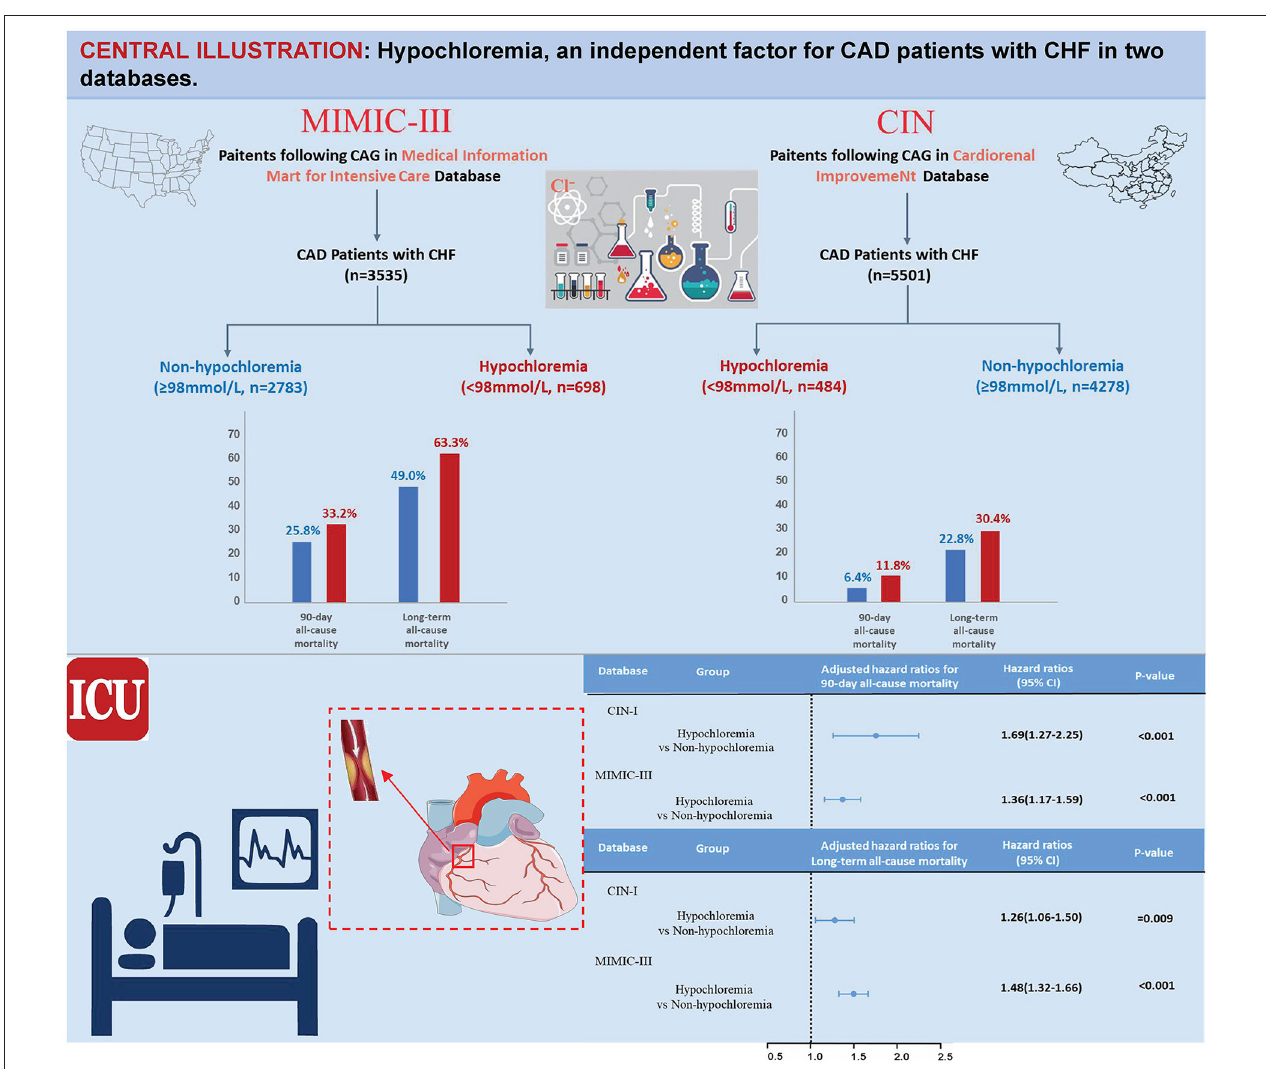
FIGURE 5 | Central